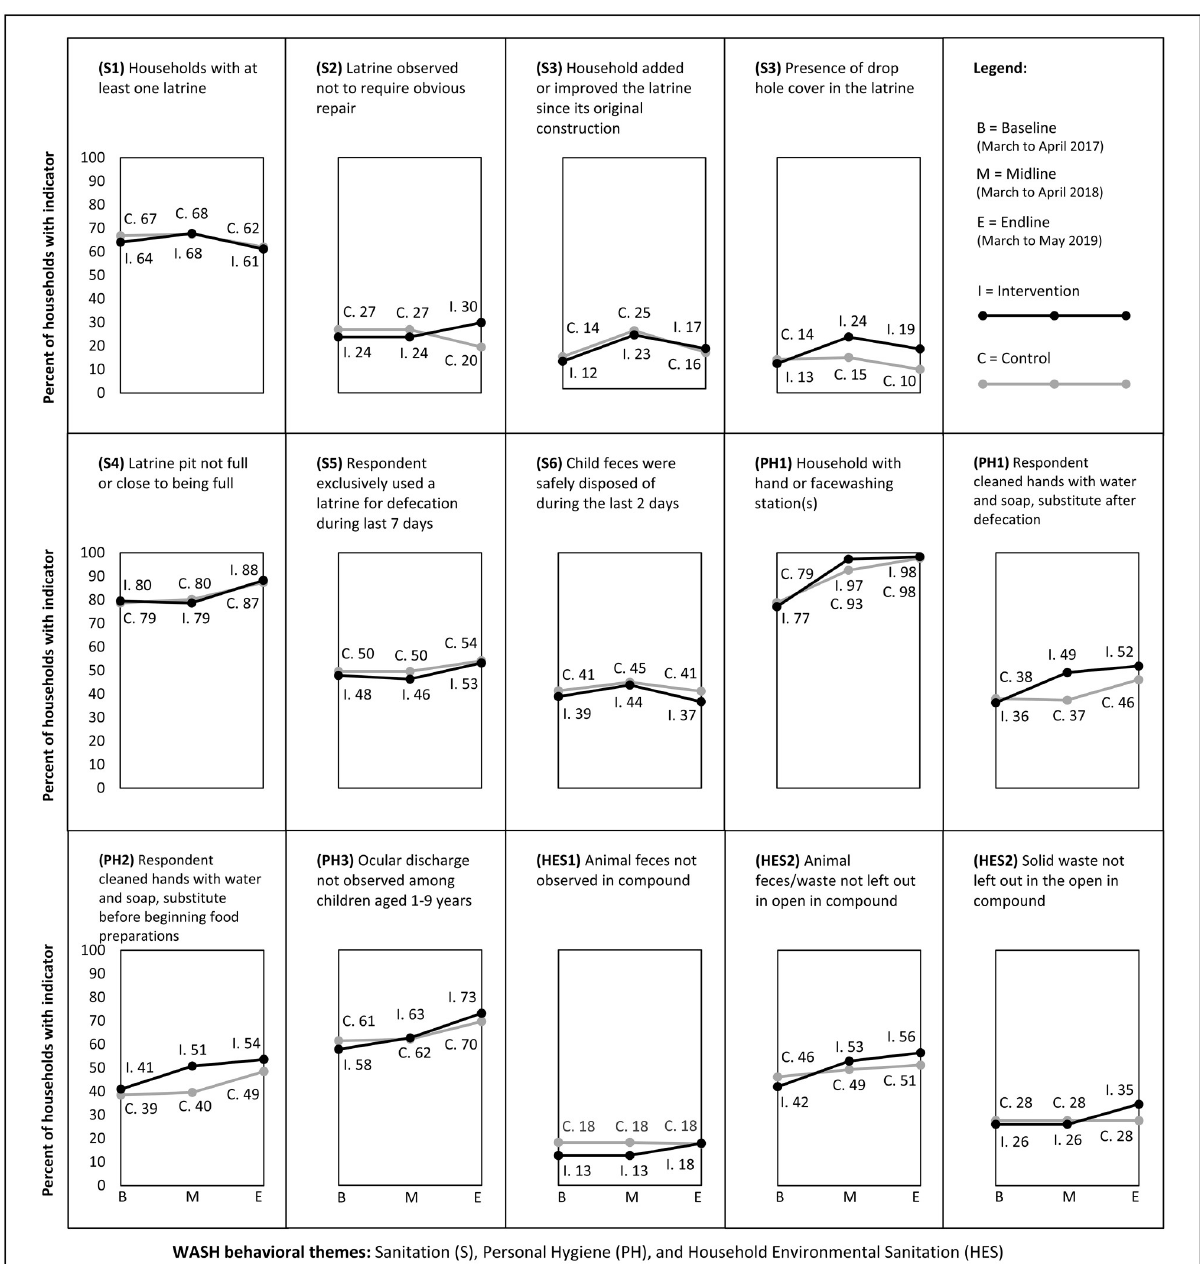
Fig 4. The prevalence of key sanitation, personal hygiene, and household environmental sanitation indicators over time. Table 3). Among index children, there were also similarities comparing study arms in diarrhea prevalence when assessing episodes over the last two days (PR: 1.25; 95% CI: 0.71, 2.22). Water and sanitation insecurity. The intervention did not statistically reduce water inse- curity prevalence between intervention (5.7%) and control (8.8%) arms (PR: 0.50 (95% CI: .21, 1.2); Table 3). At endline, sanitation insecurity scores related to social support were statistically lower (i.e., better) in the intervention arm than in the control arm (score difference: -0.10, 95%